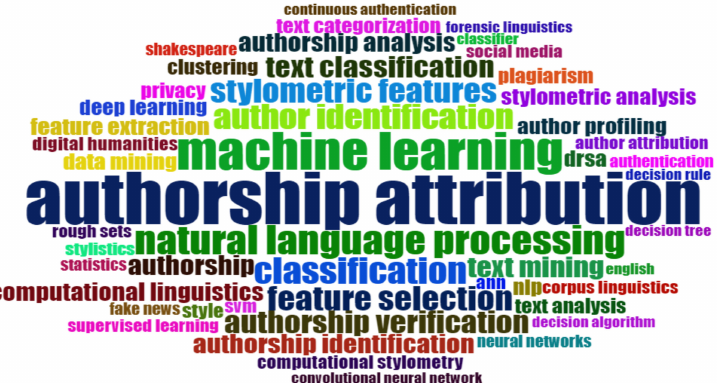
Figure 7. Word cloud based on author keywords (this word cloud was generated by